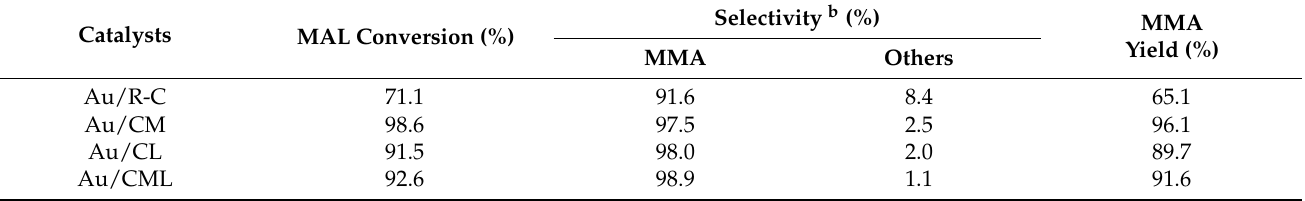
Table 4. Catalytic performance of the catalysts a .